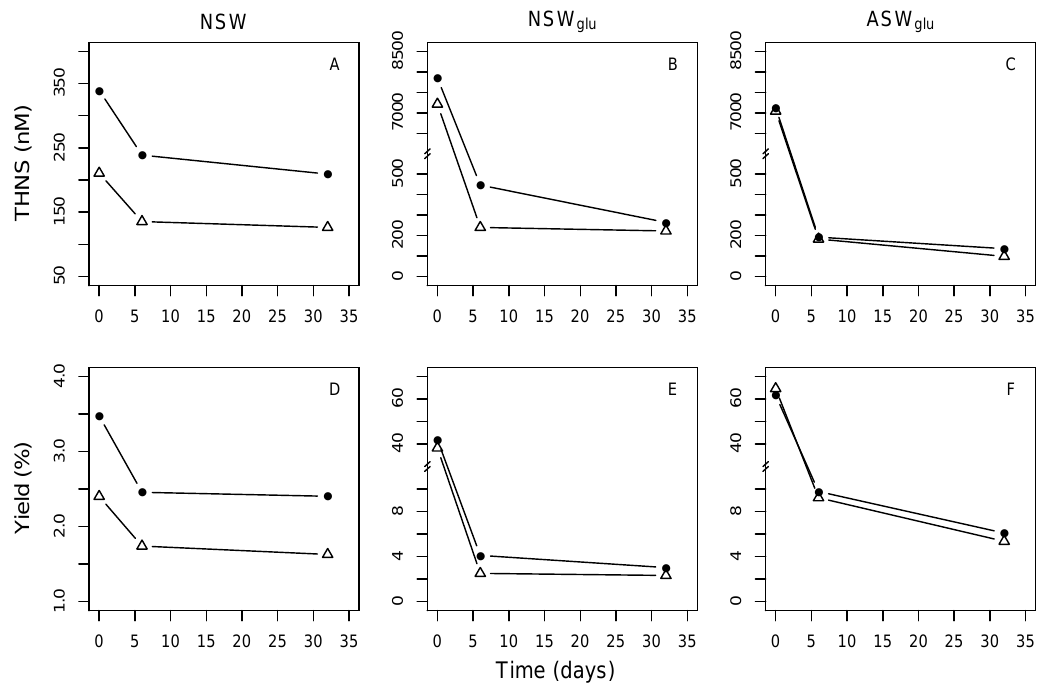
Figure 3. Concentration and yield of total hydrolyzable neutral sugars (THNS). • represents Atlantic treatments and 1 represents Arctic treatments. Note the different scales of the axes and the broken axes on the plots of the glucose-enriched treatments.